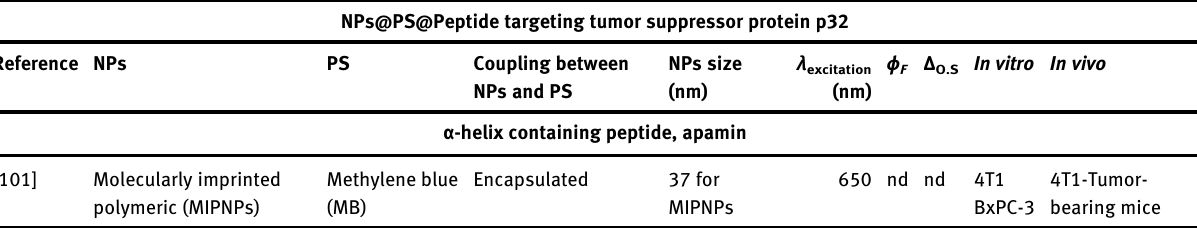
Table  : The summary of NPs conjugated with PSs and peptides targeting tumor suppressor protein p  in terms of different